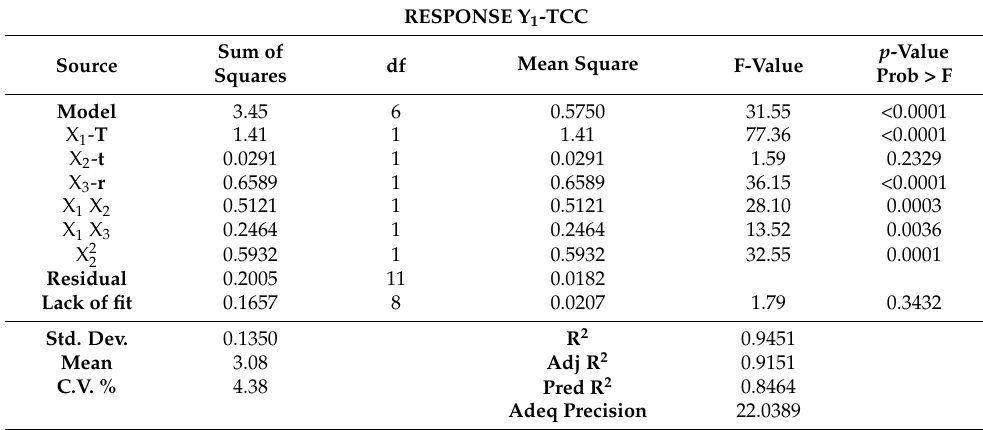
Table 4. Analysis of variance (ANOVA) and measures of the model’s prediction